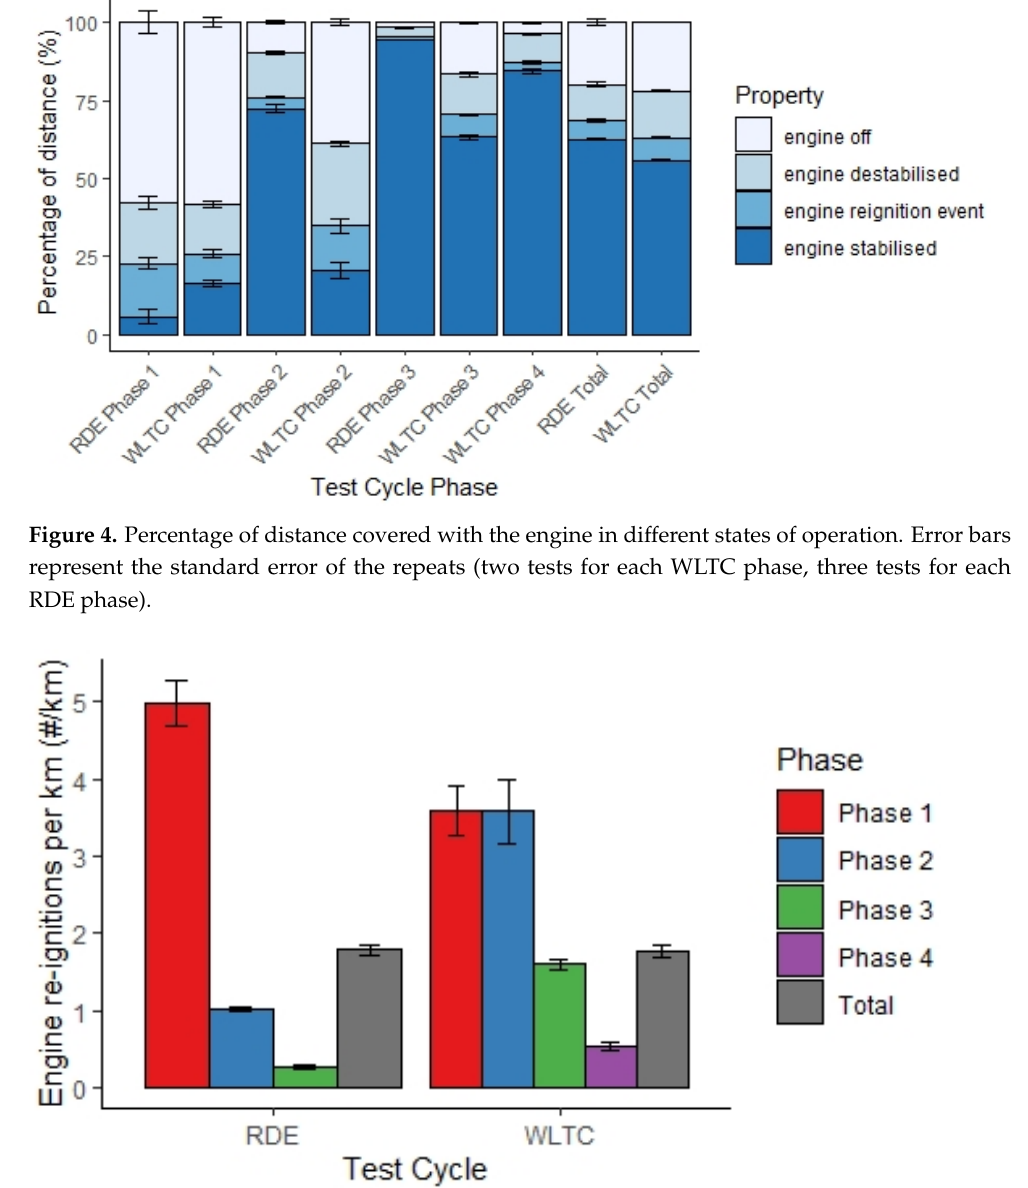
Figure 5. Number of engine re-ignition events per km for the total WLTC and RDE-style test cycles and their individual phases. RDE phases are called phase 1 (urban), phase 2 (rural) and phase 3 (motorway) for comparison with the WLTC cycle phases. Error bars represent the standard error of the repeats (two tests for WLTC, three tests for RDE).